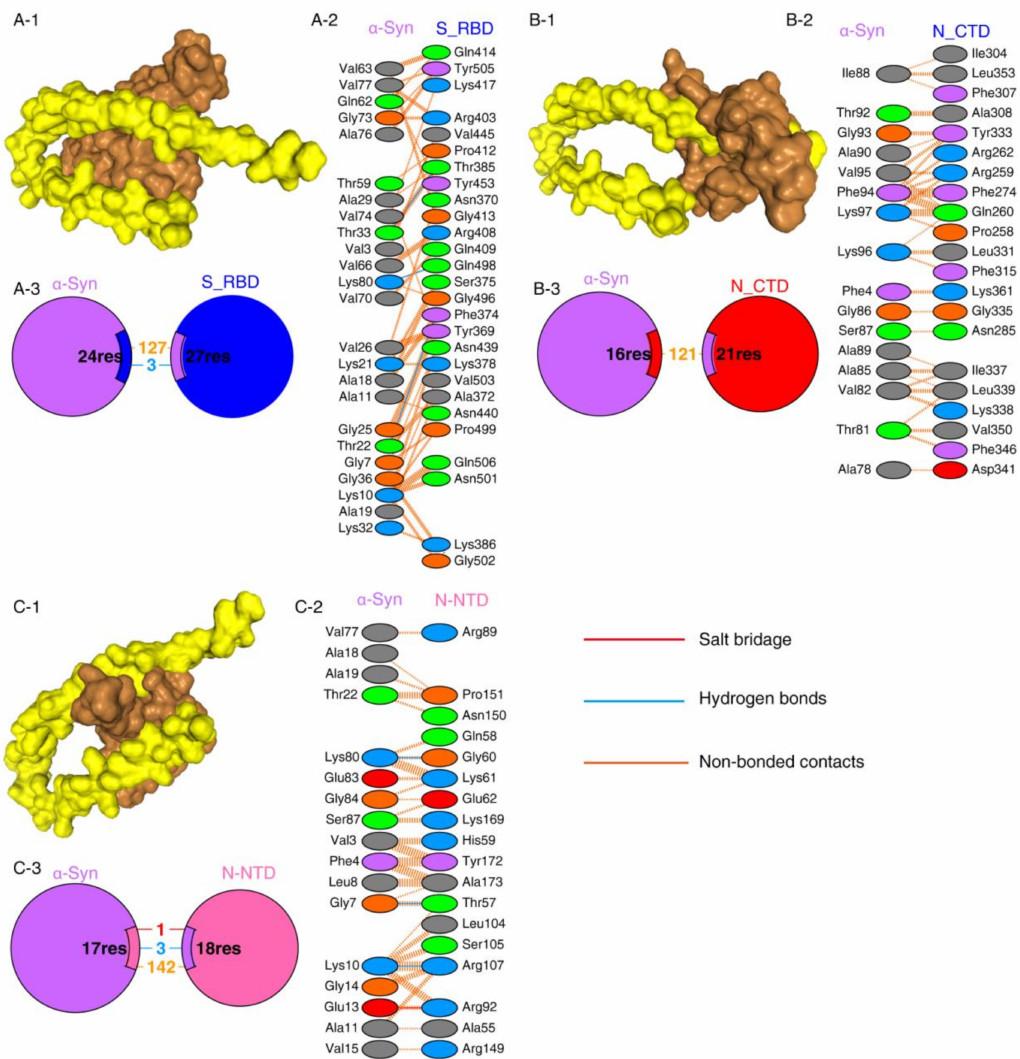
Figure 1. SARS-CoV-2 proteins’ interaction with α -Syn by protein–protein docking. ( A ) The protein– protein docking result of S_RBD (PDB ID: 1XQ8) and α -Syn. ( A-1 ) Docking model showing the interaction of S_RBD (brown) and α -Syn (yellow). ( A-2 ) Detail of the interacting residue of S_RBD and α -Syn. ( A-3 ) Pie chart shows the key interaction of residues between S_RBD and α -Syn. ( B ) The protein–protein docking result of N_CTD (PDB ID: 6WJI) and α -Syn. ( B-1 ) Surface diagram of N_CTD (brow) and α -Syn (yellow) complex model. ( B-2 ) Detail of an interacting residue of N_CTD and α -Syn. ( B-3 ) Pie chart shows the key interaction of residues between N_CTD and α -Syn. ( C ) The protein– protein docking result of N_NTD (PDB ID: 6VYO) and α -Syn. ( C-1 ) Docking model of interaction of N_NTD and α -Syn. ( C-2 ) Detail of an interacting residue of N_NTD and α -Syn. ( C-3 ) Pie chart shows the key interaction of residues between N_NTD and α -Syn. Key interactions between residues are presented as dotted lines. The key interactions are color coded as follows: salt bridge (red), disulfide bonds (yellow), hydrogen bonds (blue), and non-bonded contacts (orange). The number of lines indicates the potential number of bonds. For non-bonded contacts, the width of the striped line indicates the number of potential